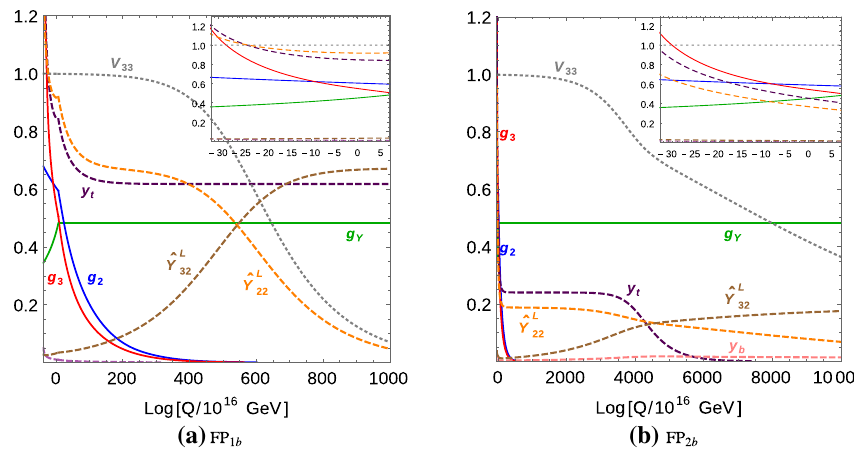
Fig. 2 RG flow of the gauge and Yukawa couplings from the trans-Planckian energies down to the EWSB scale for scenarios featuring the fixed point a FP 1 b , and b FP 2 b . The sub-Planckian flow is depicted in the inset